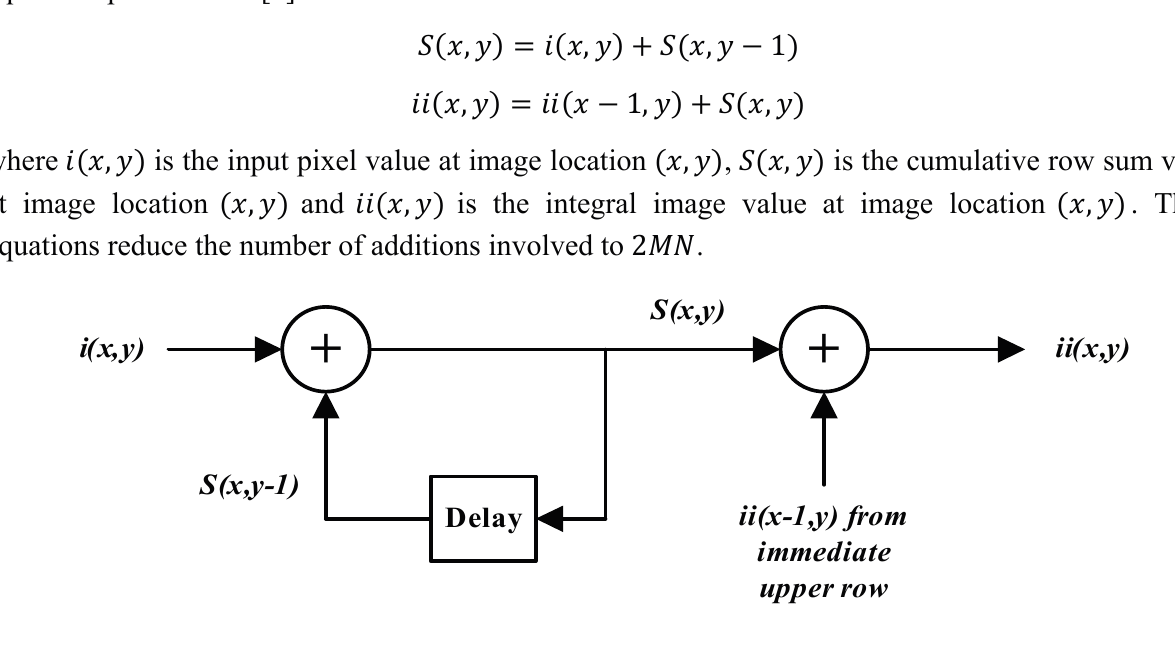
Figure 2. Data Flow Graph of the Viola-Jones recursive equations for a single row of the input